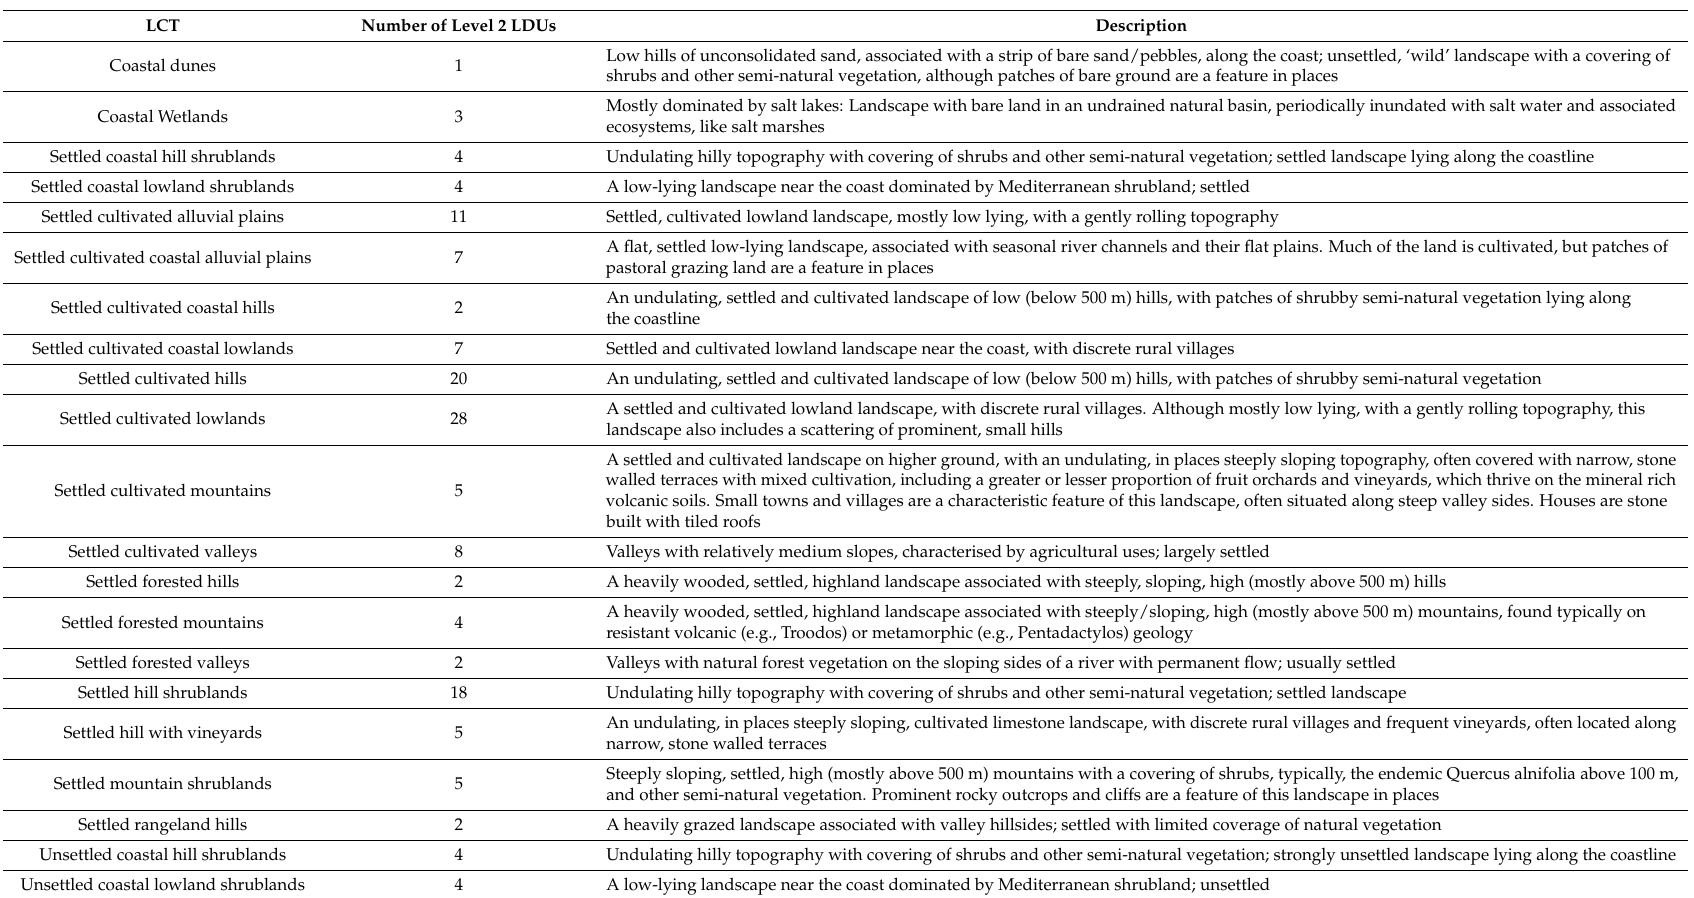
Table 2. Landscape character types (LCTs) at Level 1 within the number of Level 2 units in each